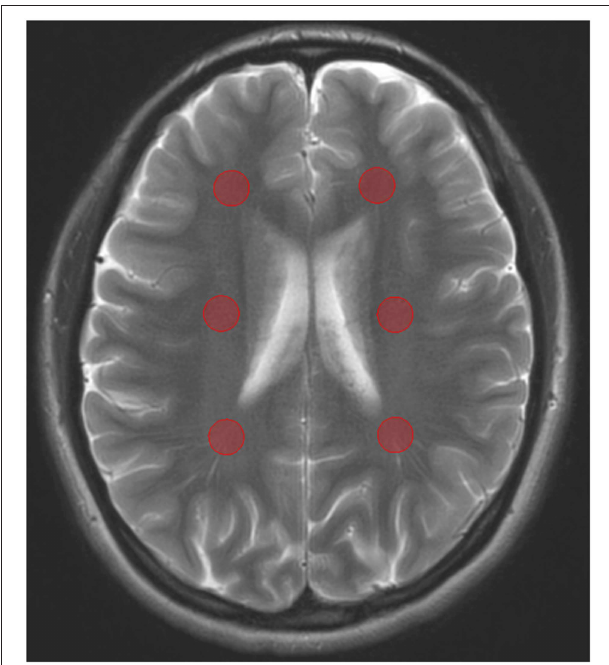
FIGURE 1 | T2w image with 0% APT image overlay. ROIs for measurements in normal white matter in healthy volunteers are performed bilaterally in the frontal white matter, in the centrum semiovale and in the parietal white matter. ROI size varied between 80 and 90 mm 2 in different healthy volunteers.